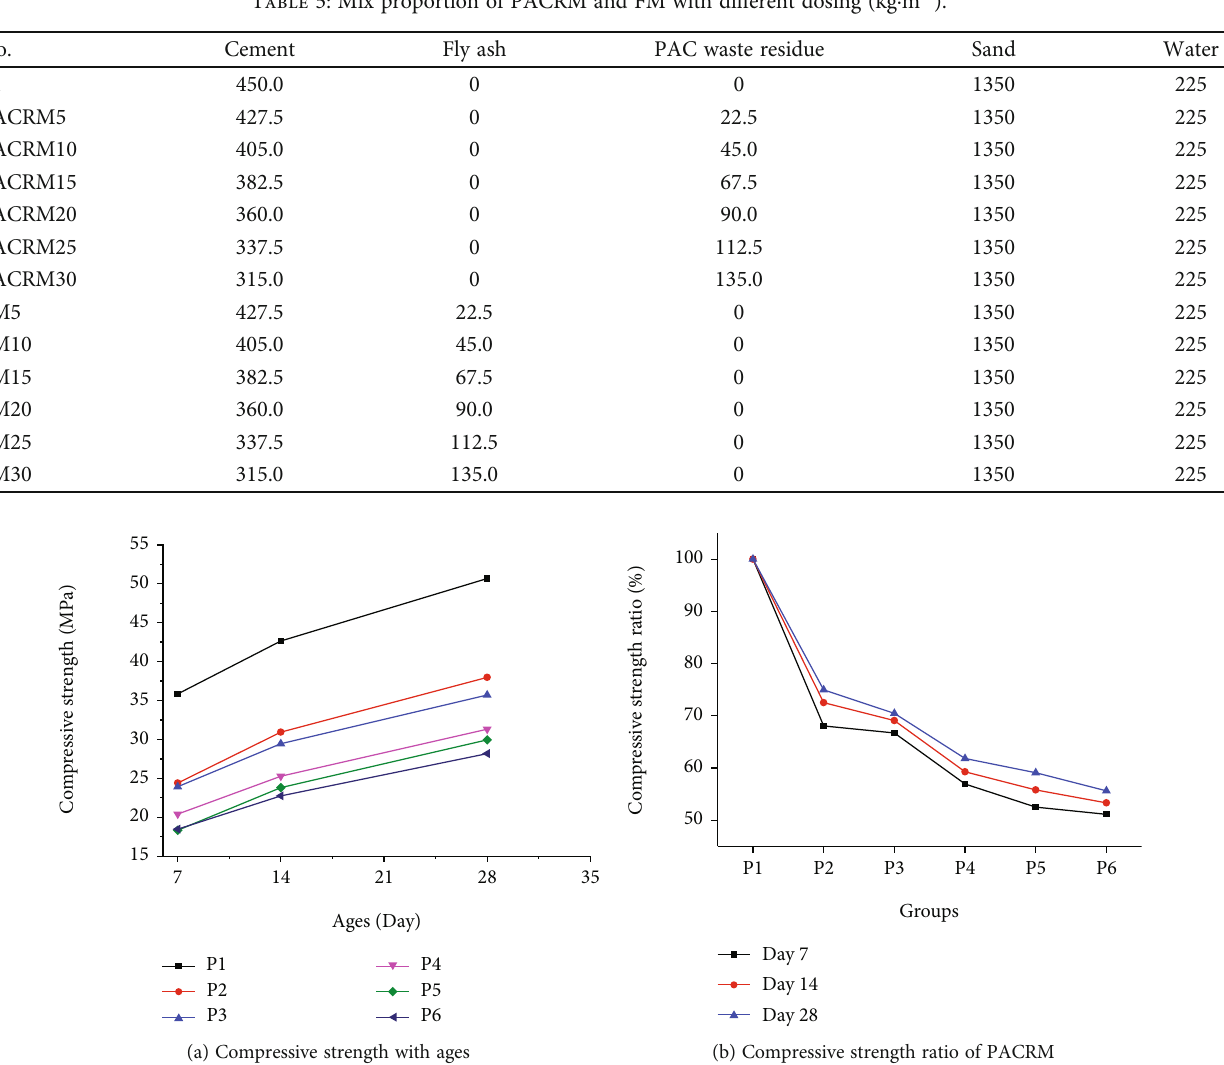
Figure 4: Trend of compressive strength and strength